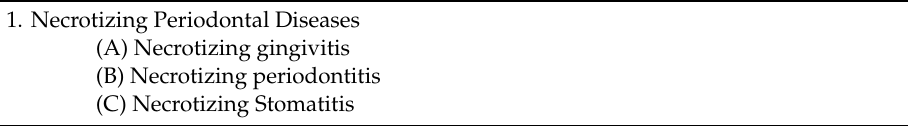
Table 5. Summary of the classification scheme AAP 2017